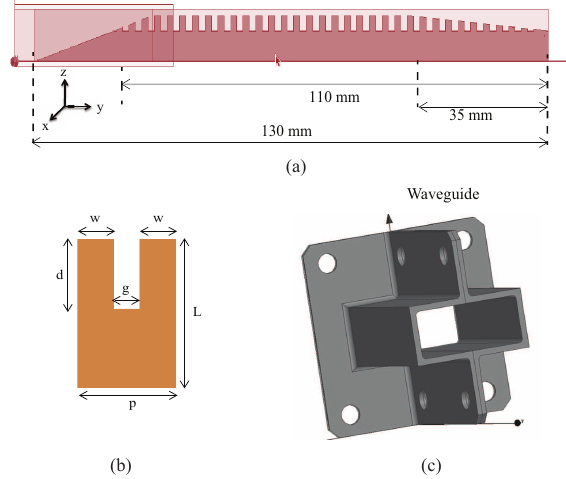
Figure 1. Geometry of the proposed design ( a ) Slow wave corrugated design with waveguide transition, ( b ) Unit element of the spoof surface plasmon (SSP) structure ( c ) waveguide transition.